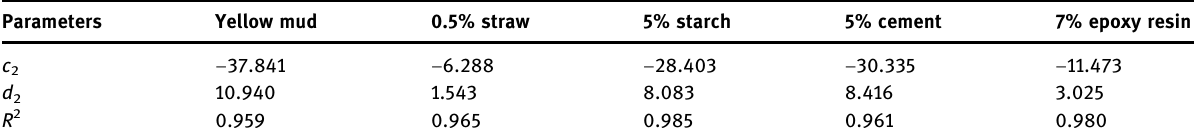
Table 7: Descending segment parameter values